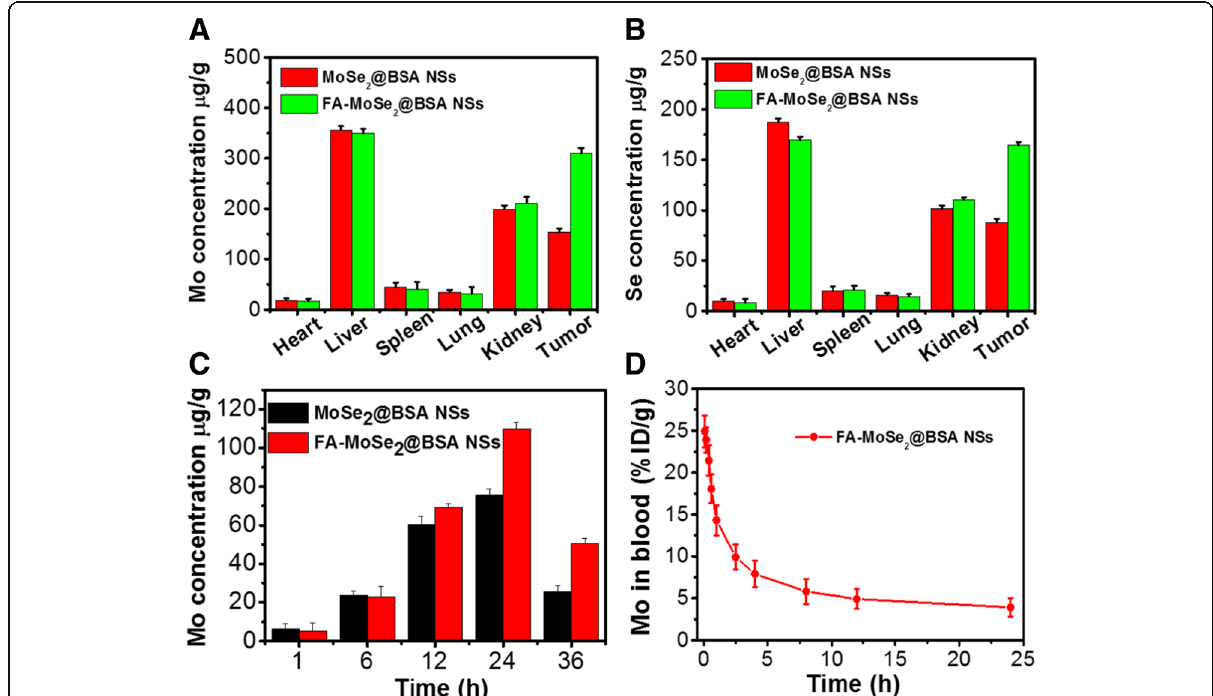
Fig. 7 The a Mo and b Se elements content of tumor and major organs including heart, liver, spleen, lung, and kidney in MoSe 2 @BSA NSs and FA-MoSe